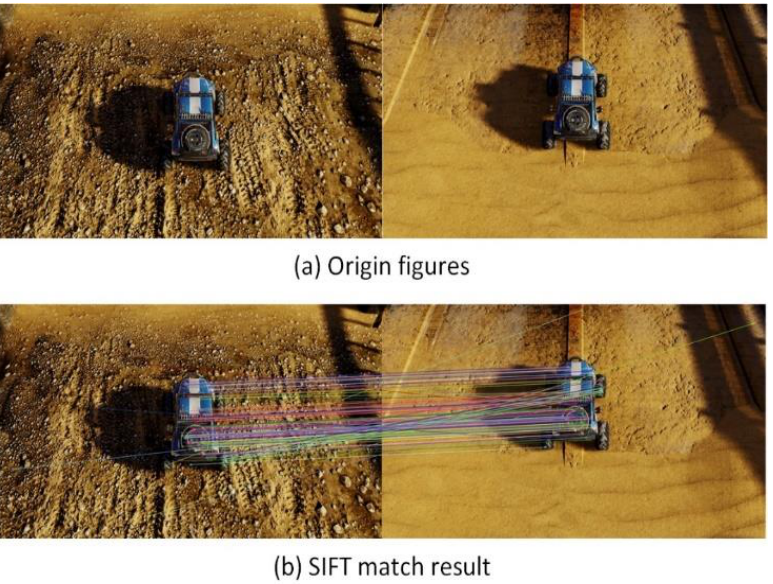
Figure 3. Invariant feature transform algorithm (SIFT) match for the same target with different scenario. ( a ) shows the origin figures. ( b ) shows the SIFT match result for the same target.